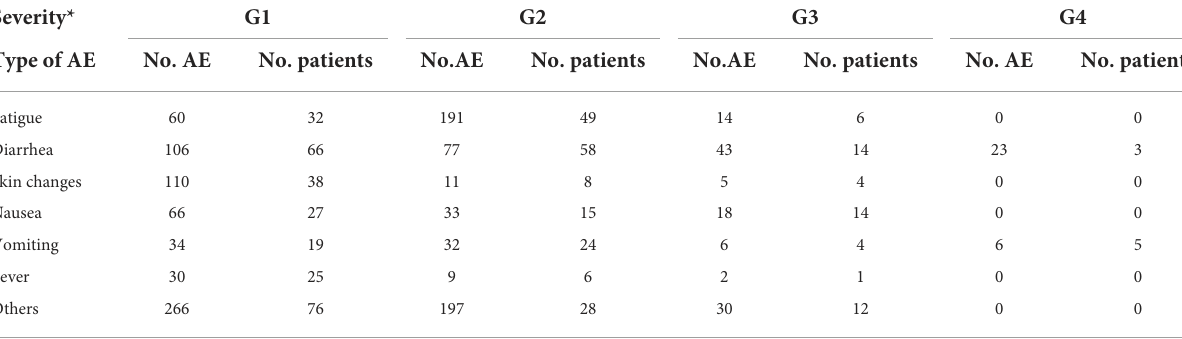
TABLE 3 Types of the adverse effects and their severity according to CTCAE clasification.